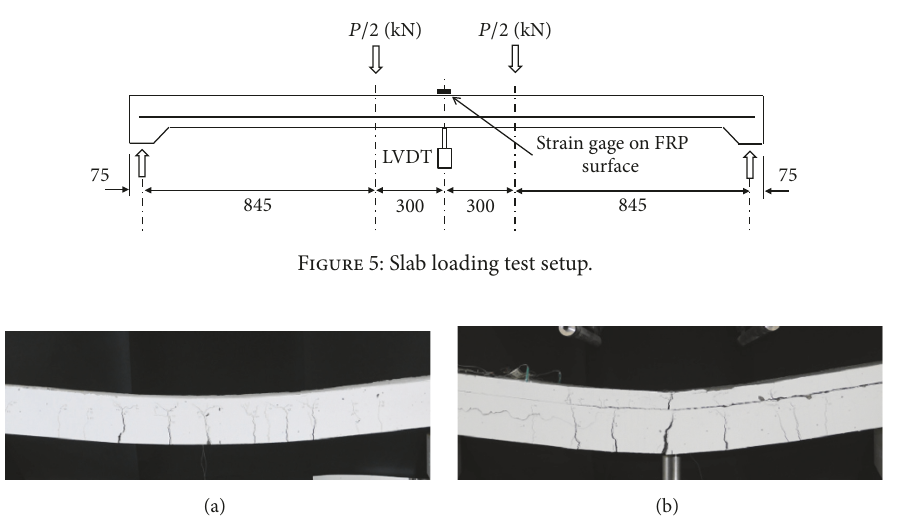
Figure 6: Midspan cracks of slabs at failure, (a) control slab and (b) retrofitted slab.